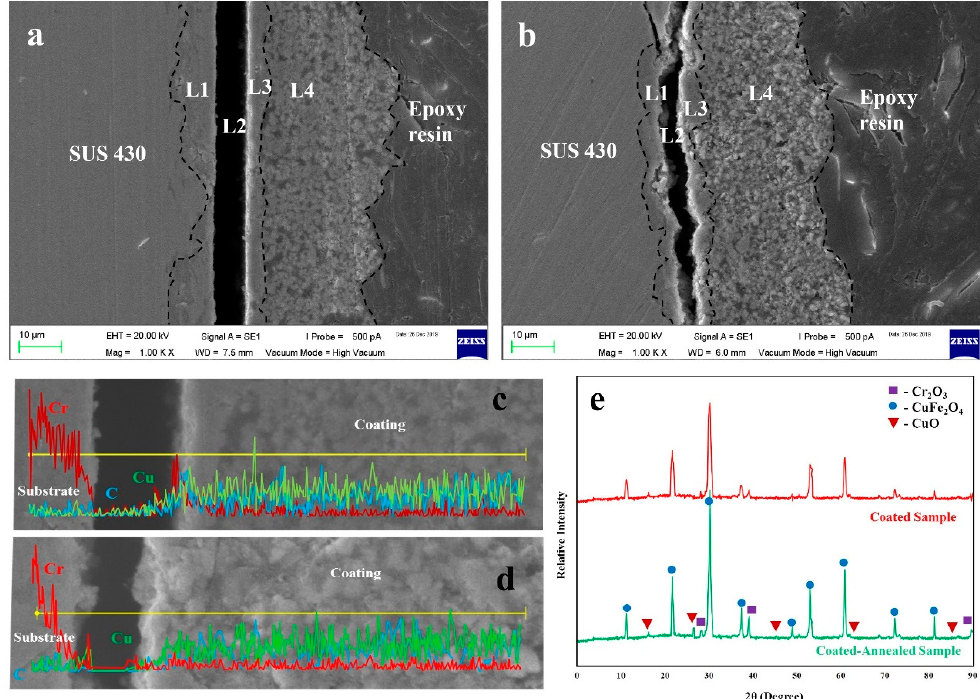
Figure 6. Results of SUS 430 before and after annealing of 6 h, ( a , b ) are SEM-Imaging, ( c , d ) are EDS-Line scanning and ( e ) is X-ray diffraction pattern, respectively.